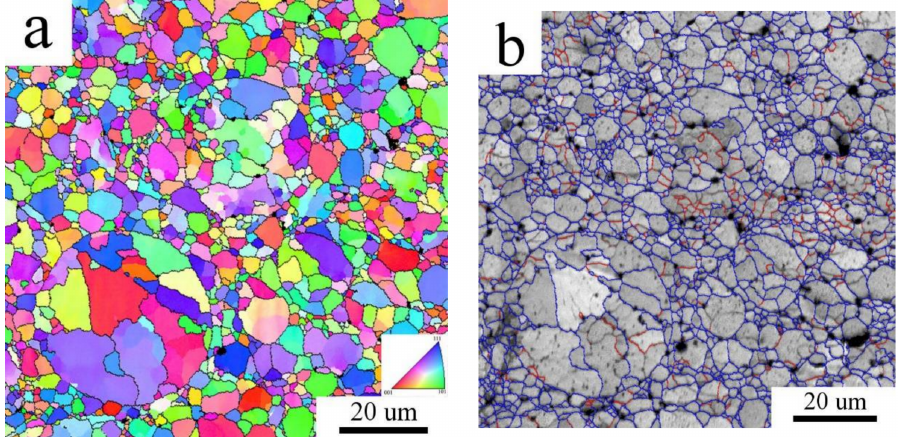
Figure 6. The EBSD micrograph of the Al7075_AC compact, ( a ) inverse pole figures; ( b ) distribution of grain boundaries, boundaries with misorientation angles above 15 ◦ in blue, boundaries between 5 ◦ and 15 ◦ in red.